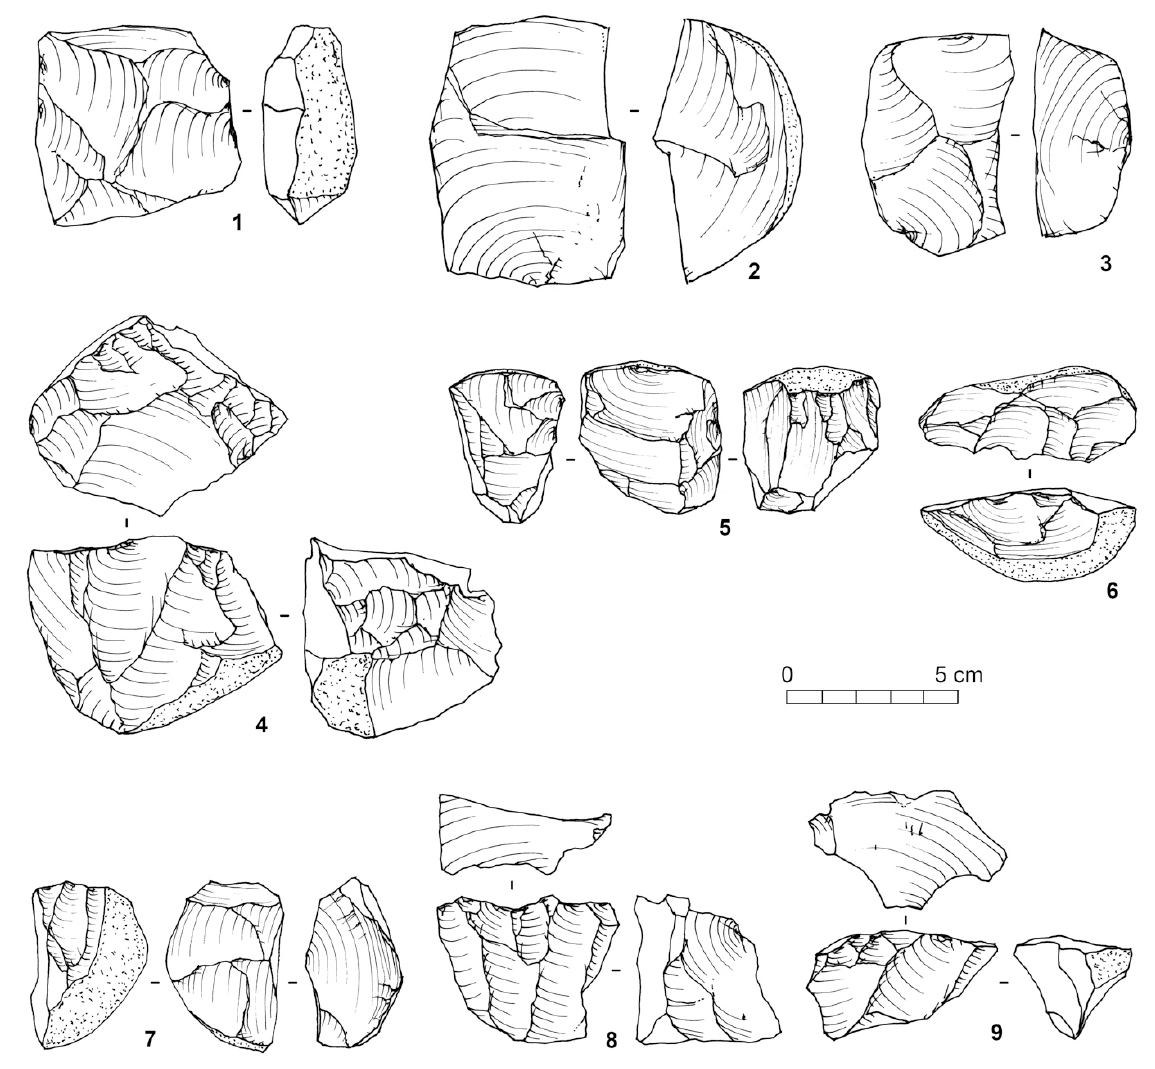
Figure 4. Cores from Square 2 of Tell Ghanem al-Ali. 1-3: cortex-platform cores with one working surface; 4-6: working-surface platform cores; 7-8: single-platform cores; 9: on-flake cores (1, 3 and 4: Level 4; 2: topsoil; 5-7, 9: Level 5; 8: Level